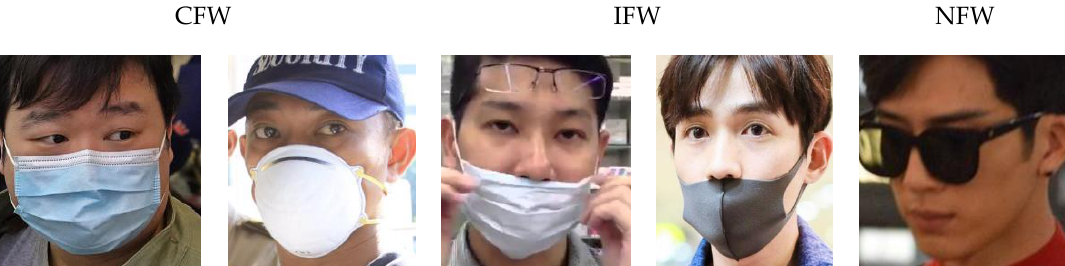
Figure 3. Examples of cropped facial images. The bounding boxes are set with some background left to avoid the face detector making bias. From our experiment, the bounding boxes are likely to have a slight drift when people are not directly facing the camera. Larger bounding boxes ensure that the facial areas are correctly cropped. Besides, more facial information is preserved with large bounding boxes. The original image was from the Medical Masks Dataset (https://www.kaggle.com/vtech6/medical-masks-dataset).